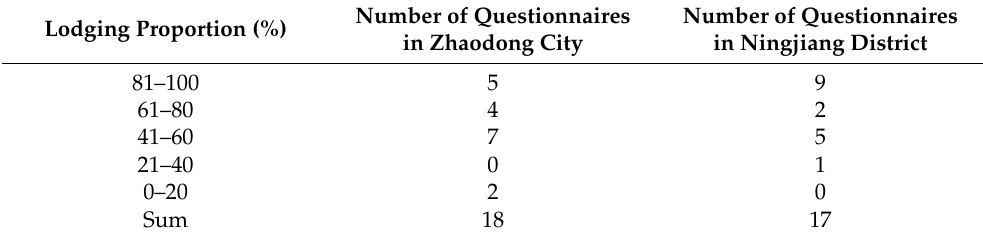
Table 4. Statistics of the lodged maize questionnaire answered by farmers.